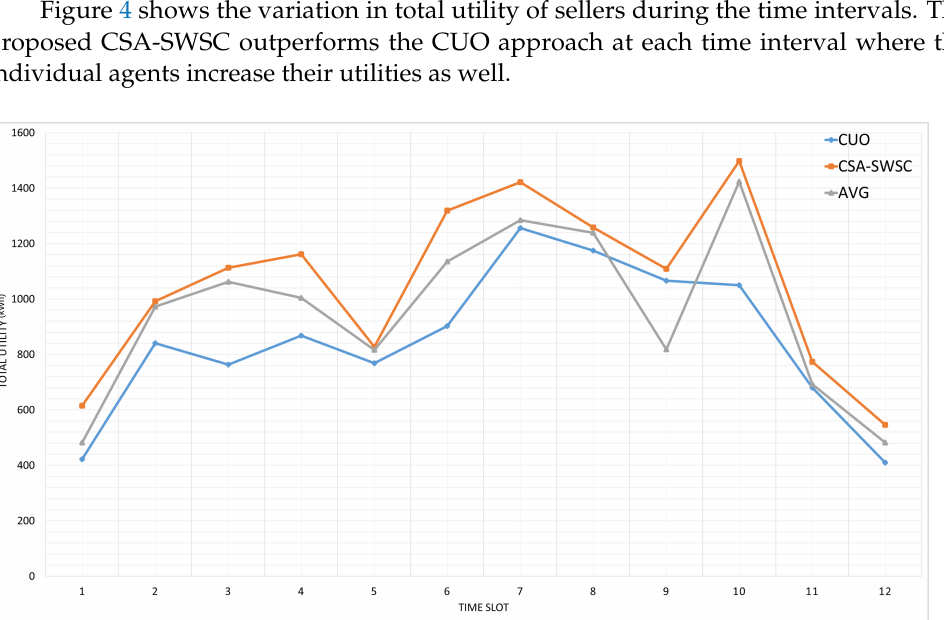
Figure 4. Total utility of